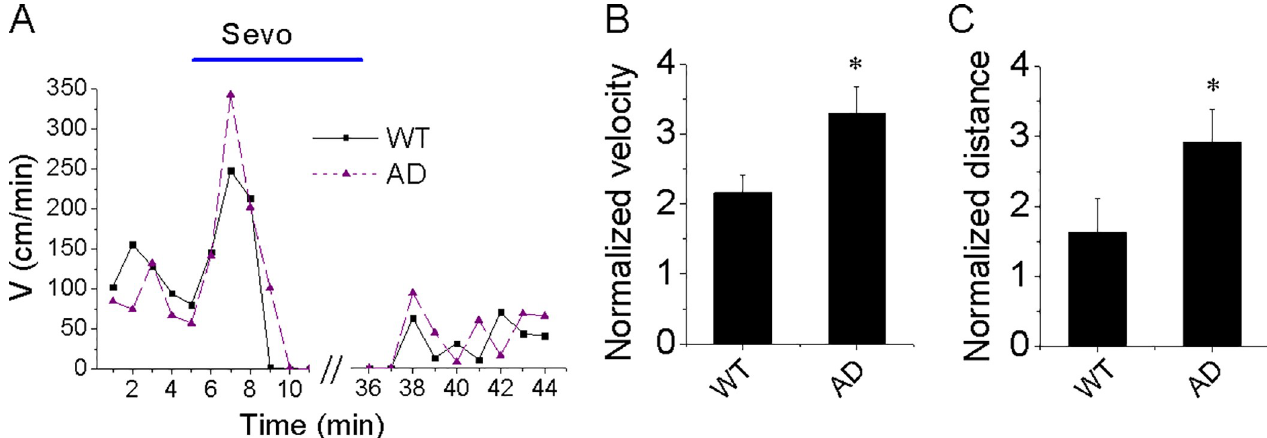
Fig 3. Sevoflurane-induced hyperactivity in AD Tg mice compared with WT mice. (A) The time-course of movement velocity in the activity chamber before and after the exposure to sevoflurane in the WT and AD Tg mice; (B&C) Summary of normalized velocity and walking distance in the induction period for each mouse type. Data shown as mean and SEM, n = 7 and 9 mice in WT and AD Tg group, respectively. Note that the sevoflurane-induced hyperactivity is increased in the AD Tg mice.